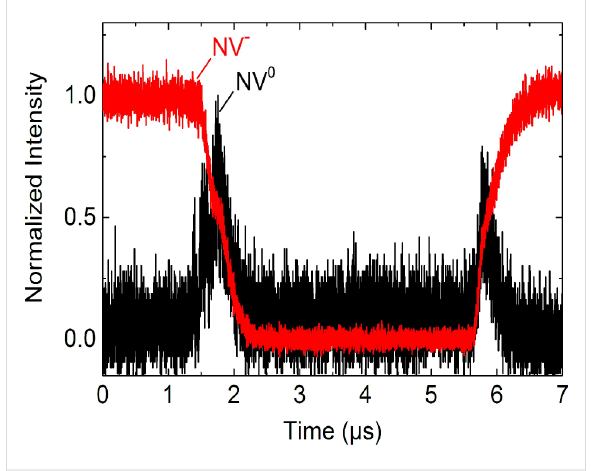
Figure 8: Simultaneous measurement of NV − and NV 0 intensity. A time-resolved measurement of NV − (red curve) and NV 0 (black curve) intensity simultaneously during switching between NV − and NV + shows that the charging and discharging process is a two-step process with NV 0 as an intermediate